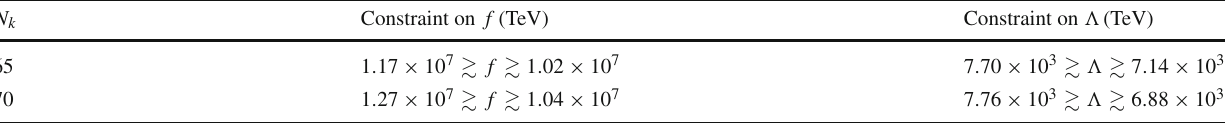
Table 2 Results for the constraints on the mass scales f and (cid:5) for Natural inflation in the high-energy of Randall–Sundrum brane model M 5 = 10 5 TeV, using the last data of PLANCK N k Constraint on f (TeV)